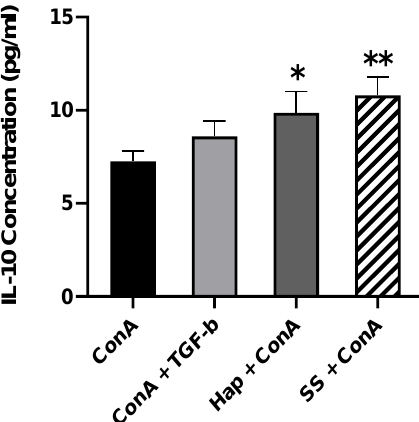
Figure 4. The secretion of IL-10 by induced SS and Harp-treated PBMCs in vitro. After 5 days of